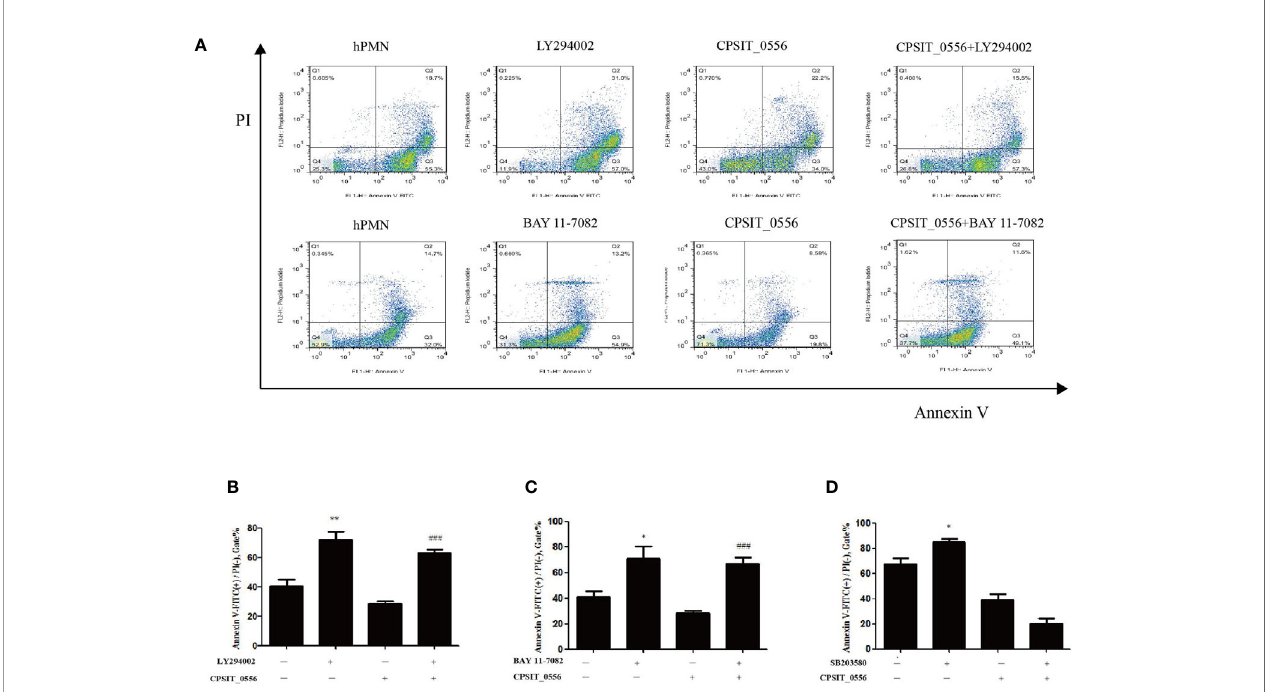
FIGURE 4 | CPSIT_0556 inhibits hPMN apoptosis through PI3K/AKT and NF- k B signaling Pathways. (A) HPMN pretreated with 25 m M LY294002 or 10 m M BAY 11-7082 for 30 min, and then incubated with CPSIT_0556 for 24 h. (B, C) The bar chart shows fl ow cytometric statistics for LY294002 or BAY11-7082 treatment of hPMN. The apoptosis rate of at least 20,000 cells was determined by fl ow cytometry of at least 20,000 cells in three separate trials. * P < 0.05 compared to hPMN cultured separately. ** P < 0.01 compared to hPMN cultured separately. ### P < 0.001 between CPSIT_0556-stimulated hPMN with and without the inhibitor BAY 11- 7082 or LY294002. (D) HPMN were pretreated with p38 MAPK inhibitor SB203580 (10 m M) for 30 min, then incubated with or without CPSIT_0556 for 24 h; data show the percentage of apoptotic cells determined by fl ow cytometry of at least 20,000 cells in three separate trials, * P < 0.05 compared to hPMN cultured